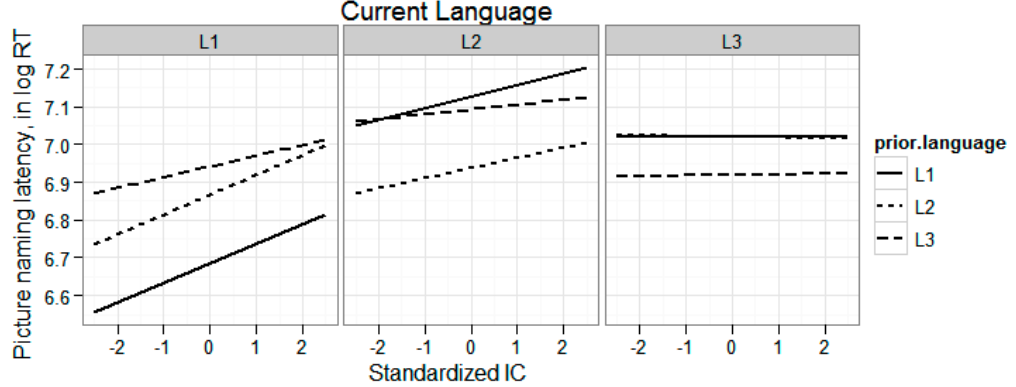
Figure 3. The relationship between inhibitory control and picture naming latencies (in log RT) within each current language and prior language condition. A larger standardized inhibitory control (IC) score indicates better inhibitory control abilities.